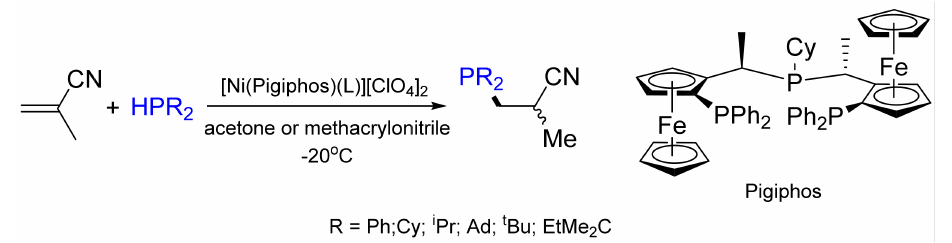
Figure 14. Ni-catalyzed asymmetric hydrophosphination of